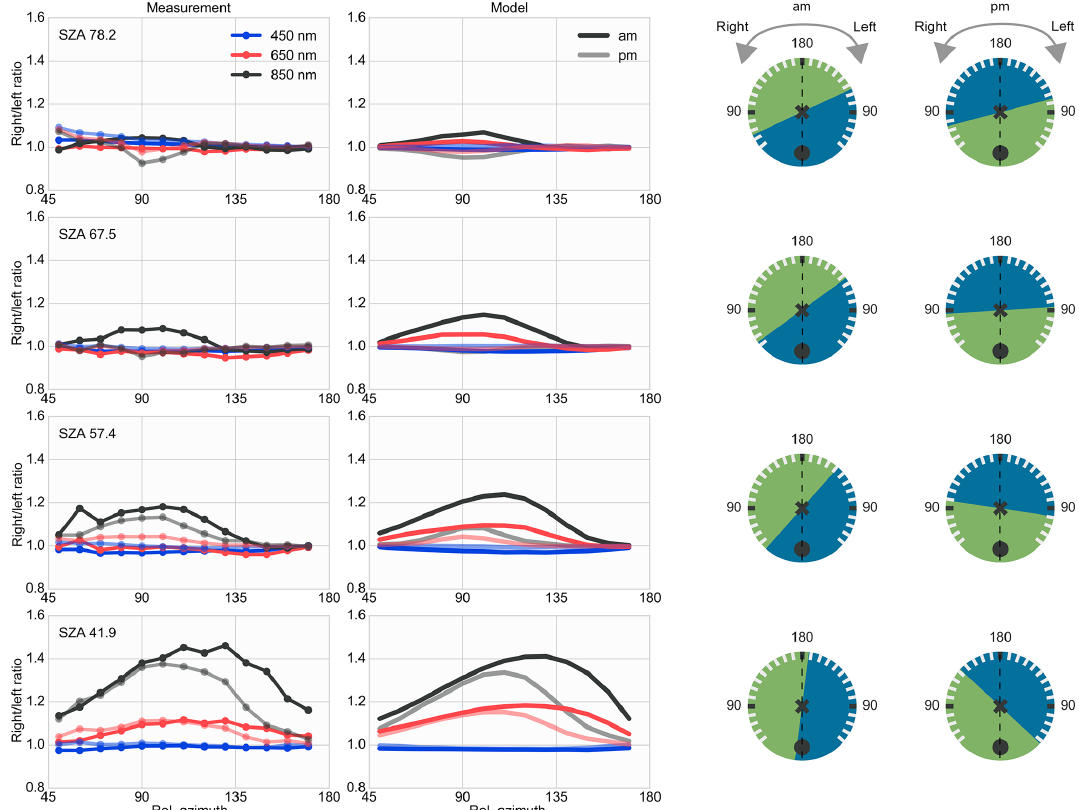
Figure 3. Asymmetry of the radiance with respect to the principal plane: right–left ratios of the radiances at 70 ◦ viewing zenith angle at three wavelengths and four SZAs at the coastal site. The azimuth is relative to the principal plane (dashed lines), which is illustrated in the sketches on the right. The plots have been rotated so that the principal plane is always vertical, which facilitates the visualization of the symmetry. At 67.5 ◦ SZA pm, the principal plane is perpendicular to the coast and the radiance distribution is symmetric with a ratio of 1. Towards noon, the ratios for the longer wavelengths increase as the principal plane aligns with the coastline and maximizes the asymmetry with respect to the high-albedo land on the right and the low-albedo ocean on the